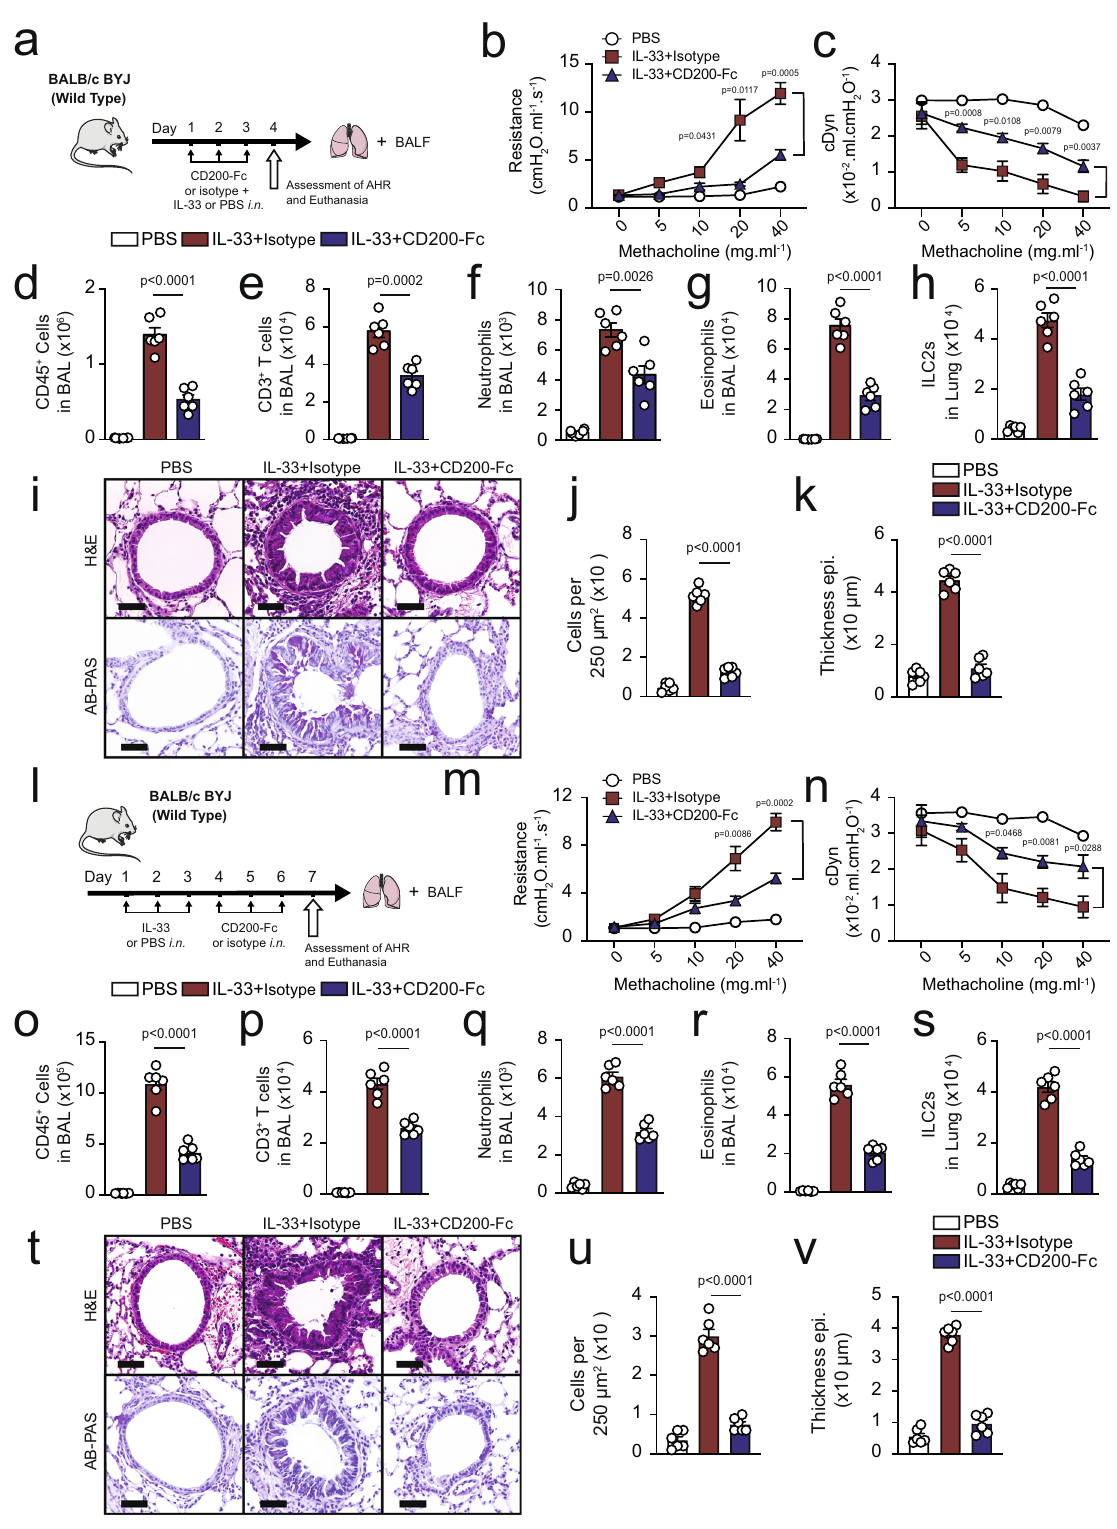
The relevant cytokine and cytokine receptor genes were displayed on the heatmap based on their modulation in response to CD200-Fc treatment (Fig. 5d). Downregulation of ILC2 relevant proin fl ammatory cytokines, such as Il5 , Il6 , Il9 , and Csf2 (GM-CSF) and upregulation of anti-in fl ammatory Il10 at a transcriptional level is consistent with our previous ex vivo data (Fig. 1g).